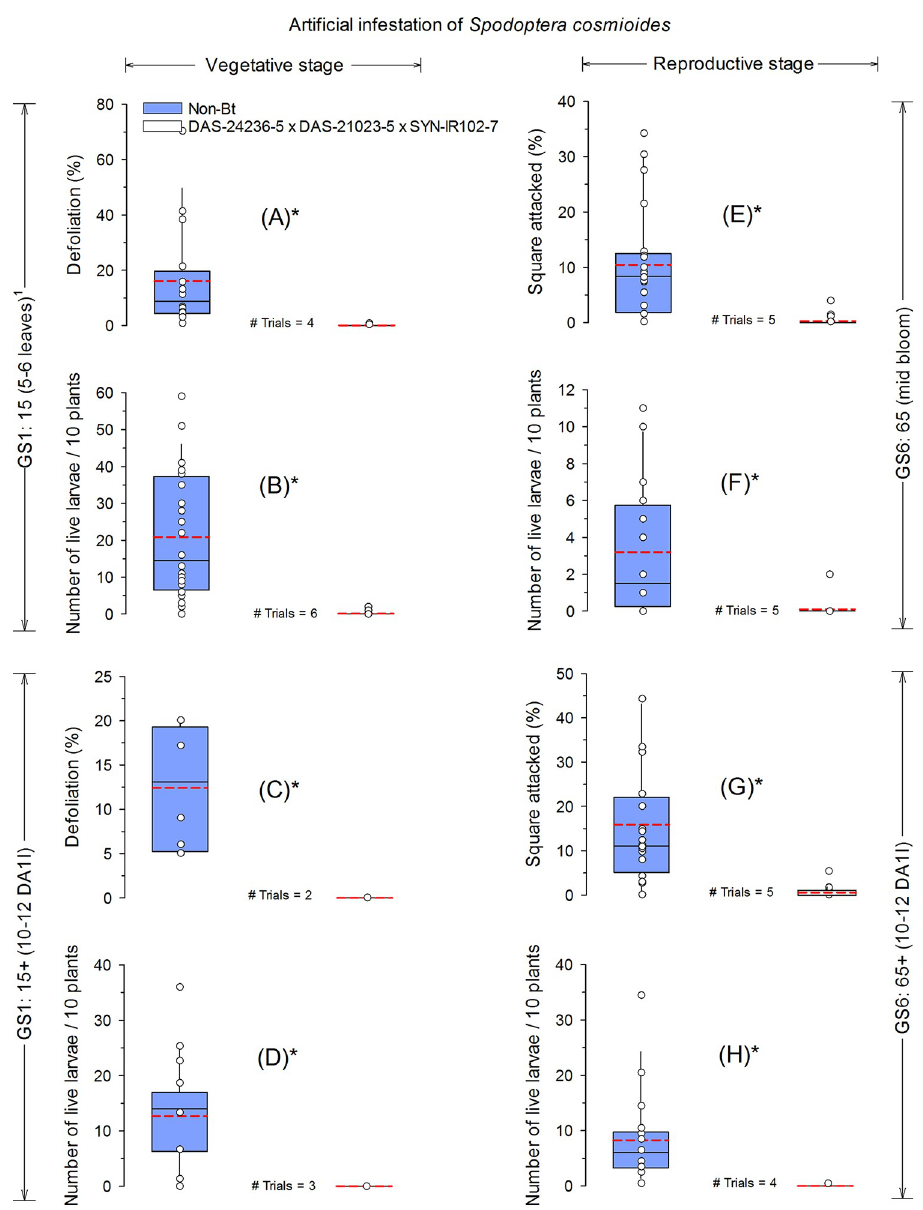
Fig 2. Efficacy of Bt cotton technology with events DAS-21023-5 × DAS-24236-5 × SYN-IR102-7 against Spodoptera cosmioides at 10 days after artificial infestations of first instar (L1) during vegetative and reproductive cotton growth stages. The dashed (red) and solid (black) lines in boxplots present the mean and median across trials, respectively. Dot markers indicate values from individual trials. � Significant difference between non- Bt and Bt cotton technology using an F -test ( α = 0.05). 1 Phenological growth stages of cotton classified according to Munger et al. (1998); DA1I = days after 1 st infestation. PRC diagram for Conchal, DAS-21023-5 × DAS-24236-5 × SYN-IR102-7 presented positive canonical coefficient ( Cdt ) at the GS1:13, GS5:51 and GS8: 85 cotton growth stages (Fig 4A). Among the NTAs that contributed most to the community response in Conchal (taxon weights > |0.5|), the predators Araneae sp. (Arachnidae), Hippodamia convergens (Coleoptera: Coccinellidae), Orius sp. (Hemiptera: Anthocoridae), and omnivores Dorymyrmex brunneus